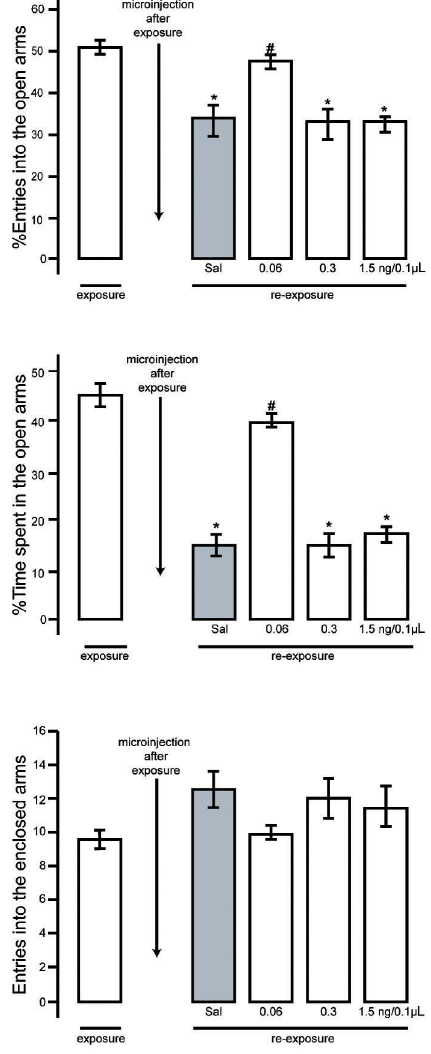
Figure 2. Effect of microinjection of thioperamide (THIO; 0.06, 0.3 and 1.5 ng/0.1 m L) and saline (Sal) into the cerebellar vermis on the percent of open-arm entries, percent of time spent in the open arms and the number of enclosed-arm entries at exposure and re-exposure. Data are reported as means±SE. *P , 0.001 re-exposure compared to exposure. # P , 0.01, THIO compared to saline at re-exposure (ANOVA followed by the Duncan post hoc